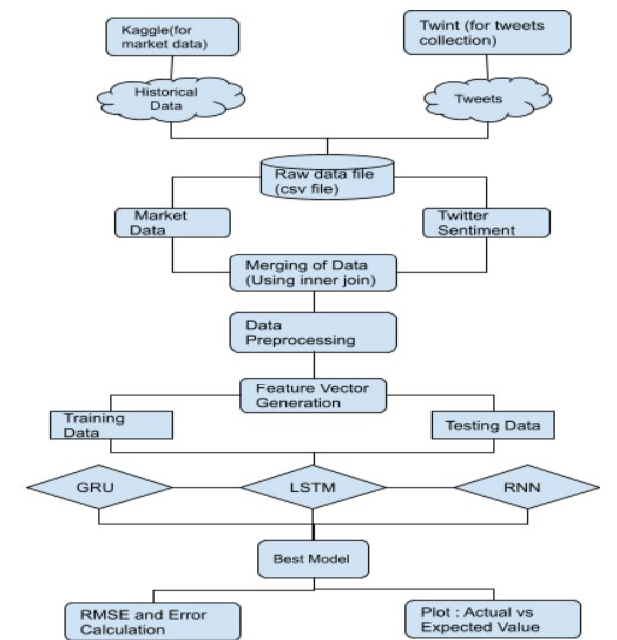
Fig. 1. Overview of the proposed approach for